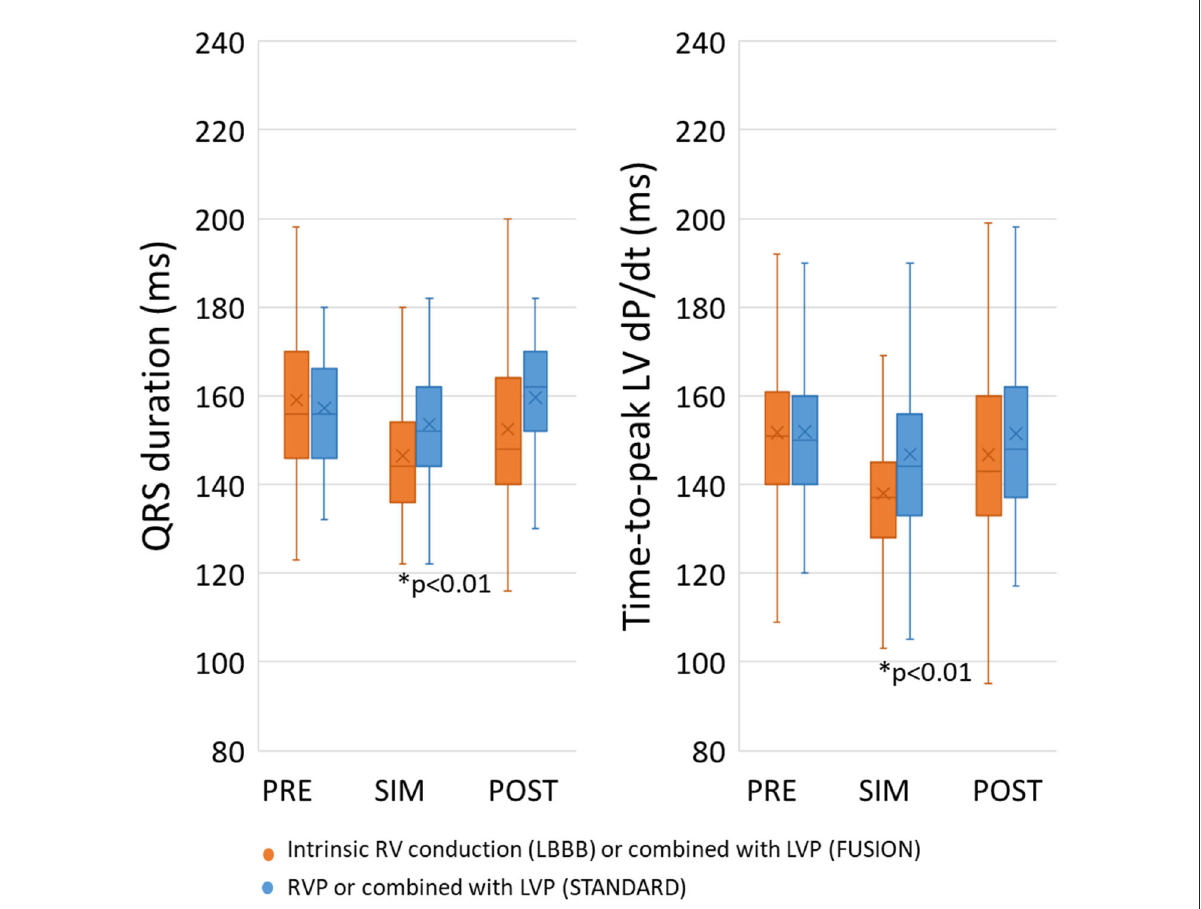
FIGURE2 Effect on LV pre-/postexcitation on QRS duration and Td. Simultaneous pacing (SIM) with intrinsic RV conduction shortened both QRS duration and Time-to-peak dP/dt compared to pre-excitation and postexcitation. PRE, pre-excitation of the LV between 75 and 25ms prior to QRS onset of RV pace onset; SIM, pacing the LV between 25ms before and 25ms after QRS onset or RV pace onset; POST, postexcitation of the LV 25–75ms after QRS onset or RV pace onset. * p < 0.01 compared to all